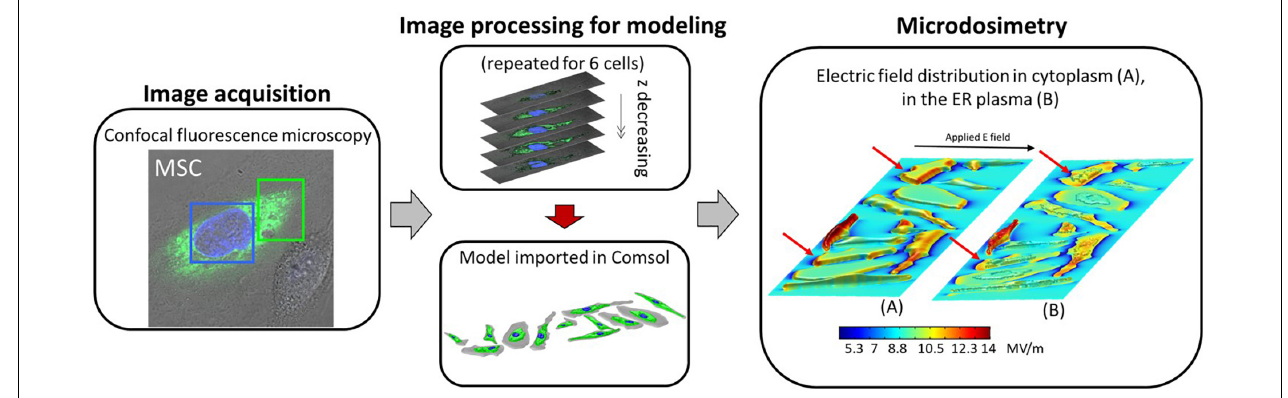
FIGURE 1 | Block scheme of the microdosimetric modeling enhanced by confocal fluorescence microscopy, from the microscopy image acquisition to the microdosimetric analysis. The six reconstructed cells were doubled and randomly placed to form the cell mixtures. In the last block “Microdosimetry,” the electric field distribution over the entire domain for one of the four investigated cell mixtures, at the time corresponding to the end of the pulse plateau ( t = 10 ns) is shown, highlighting the electric field induced in (A) the cytoplasm, and (B) the ER plasm.